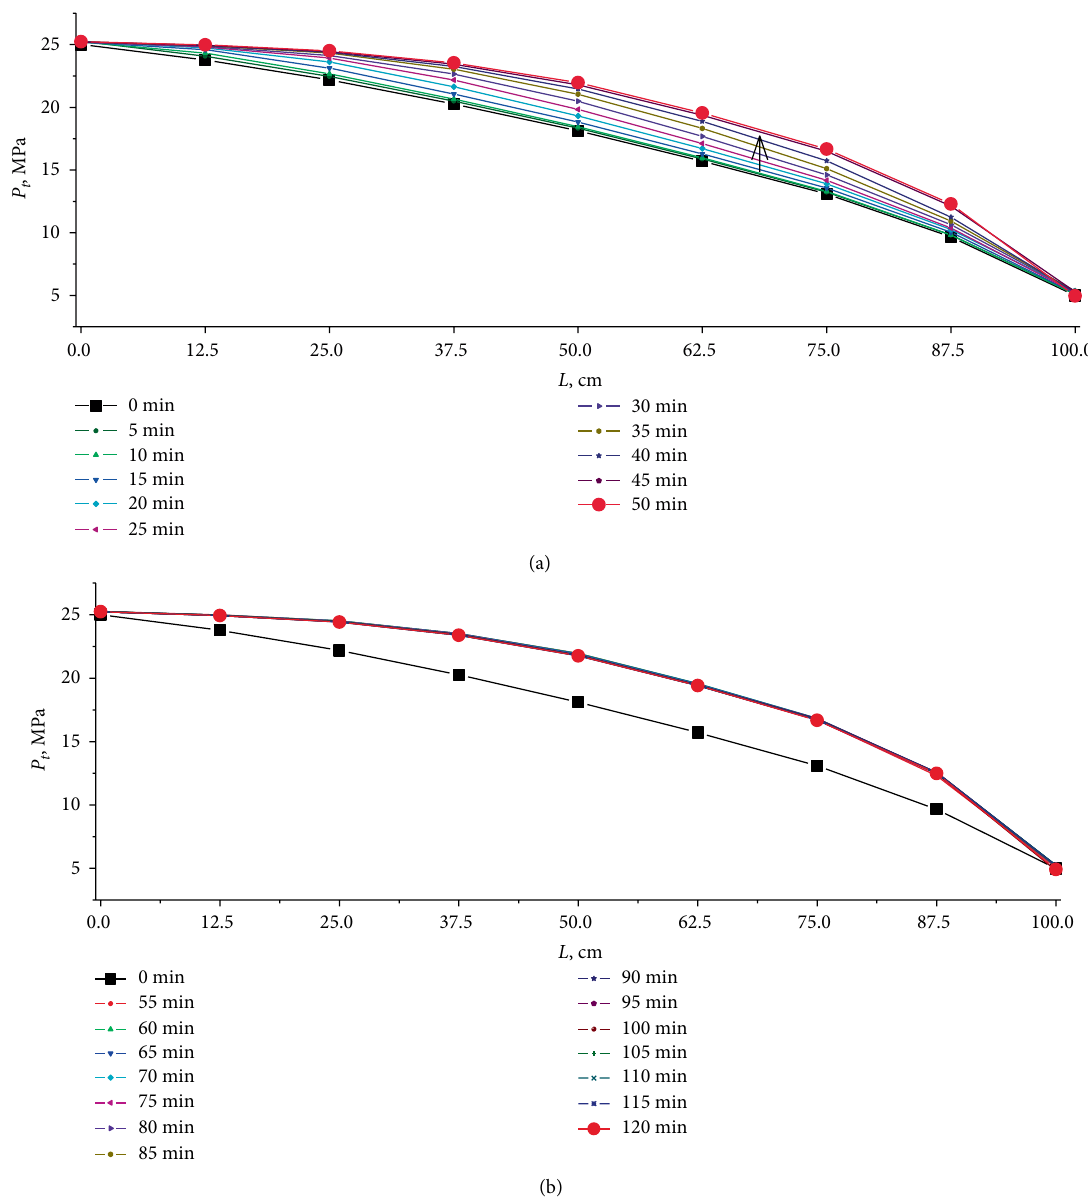
Figure 14: The pressure distribution in tight sandstone samples during N